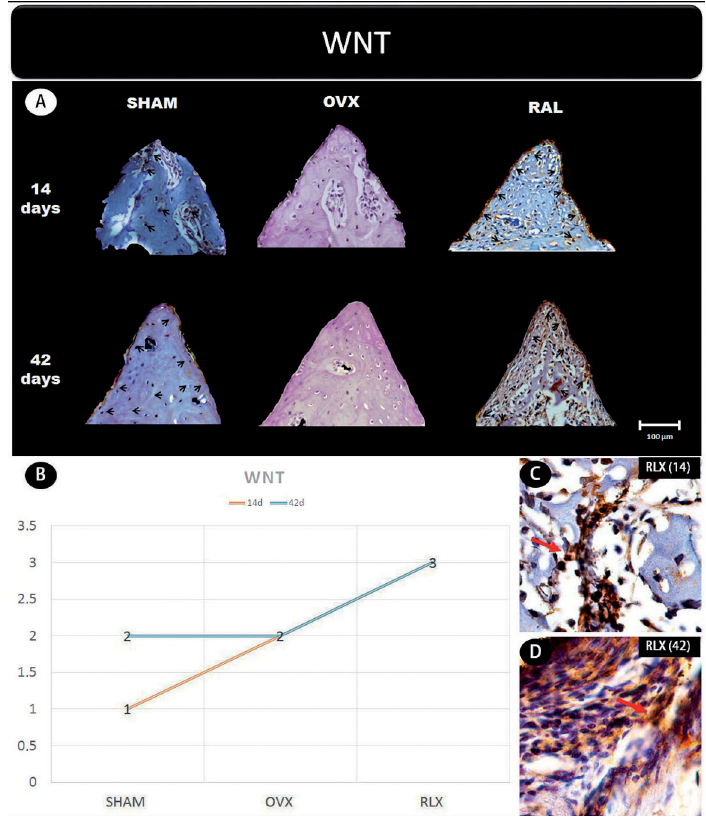
Figure 1- (A) Photomicrographs in a higher original objective (x40) of the different groups (SHAM, OVX, and RLX) and periods (14 and 42 days), in which is possible to observe an increased area of diaminobenzidine-stained cells (brown areas) around the peri-implant bone where the biomarker WNT were intense, represented by black arrows, denoting an improvement in the bone formation; (B) The chart shows the scores submitted to the Kappa test, in which the index was adjusted to >0.8, representing the expression of WNT among the groups and in both periods; (C and D) Photomicrographs in a higher original objective (x100) about the 14 and 42 days of peri-implant bone healing from RLX group showing an intense labeling of WNT pathway represented by red